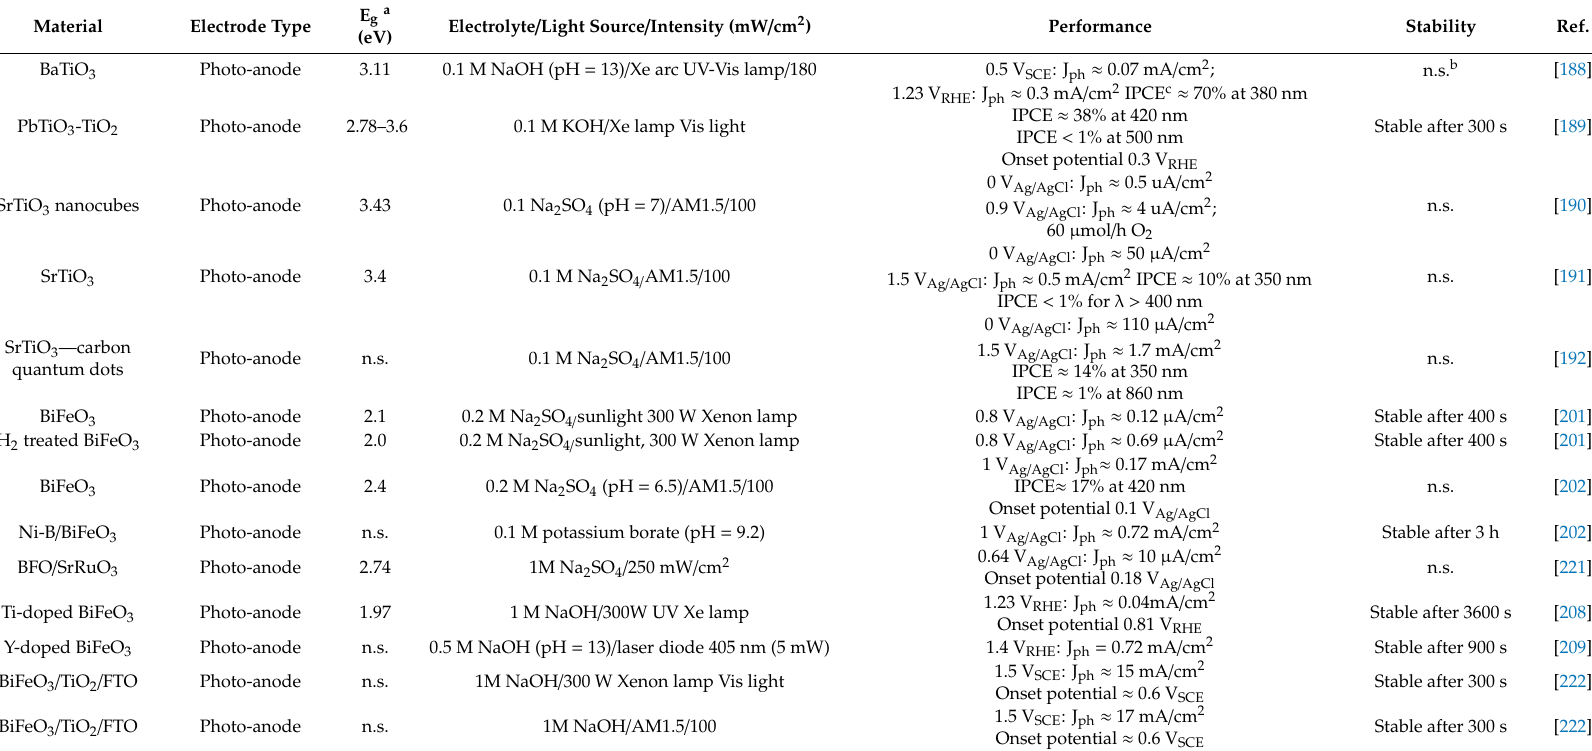
Table 8. Photoelectrodes based on perovskites for photoelectrochemical water-splitting